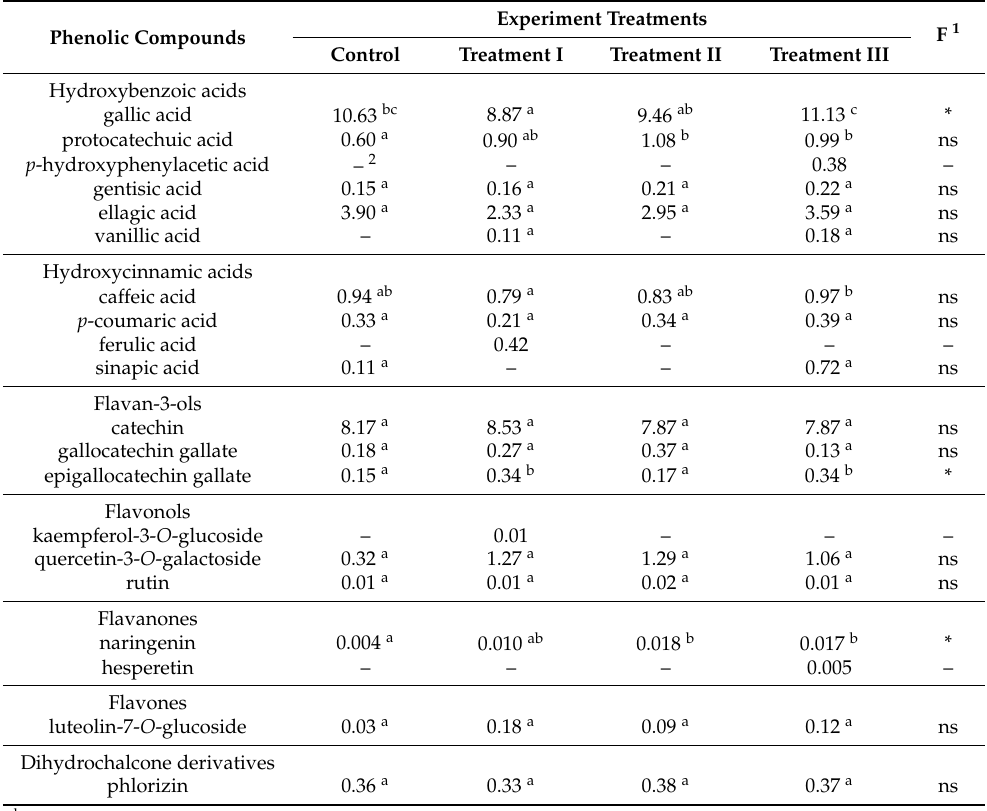
Table 1. Phenolic compound contents of wine mg/L (average for three